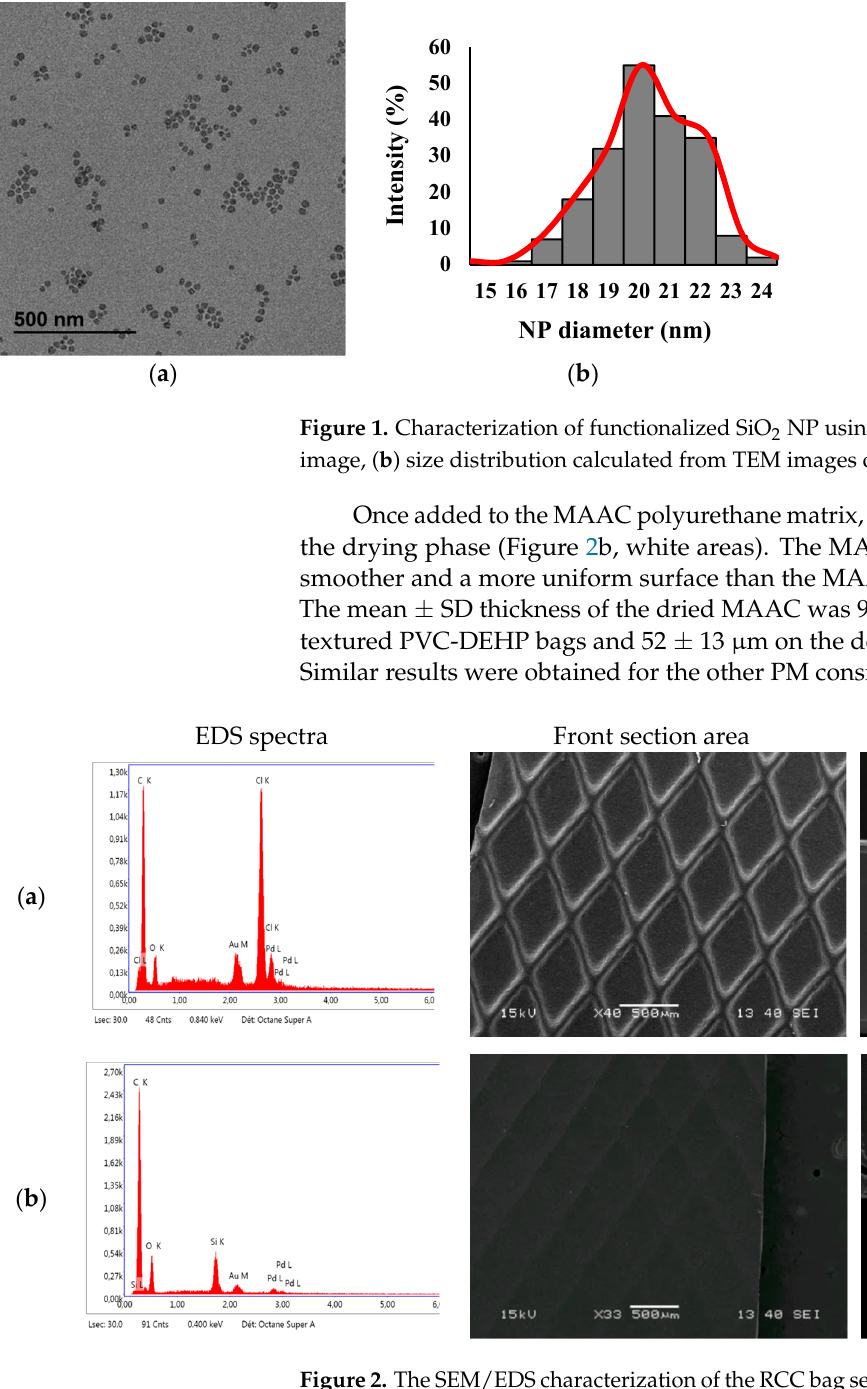
Figure 2. The SEM/EDS characterization of the RCC bag sections. The SEM images of the ( a ) uncoated and ( b ) MAAC-coated PVC-DEHP samples.